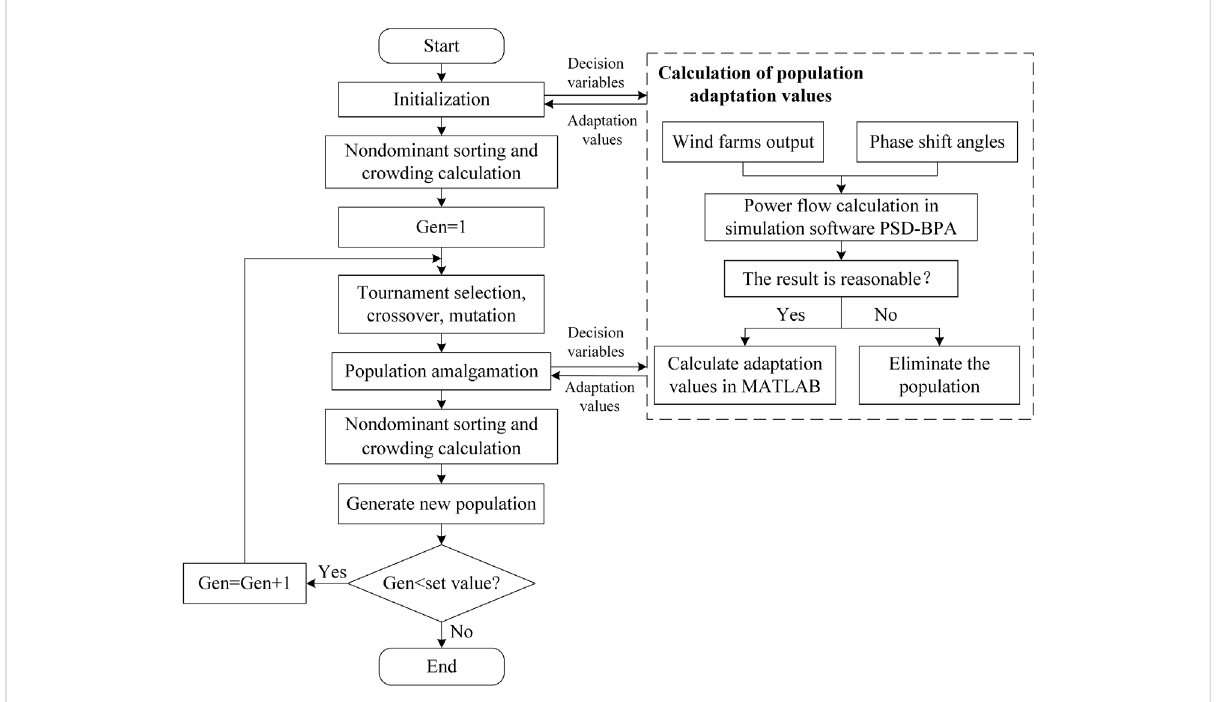
FIGURE 3 The fl ow chart of the multi-objective optimization model